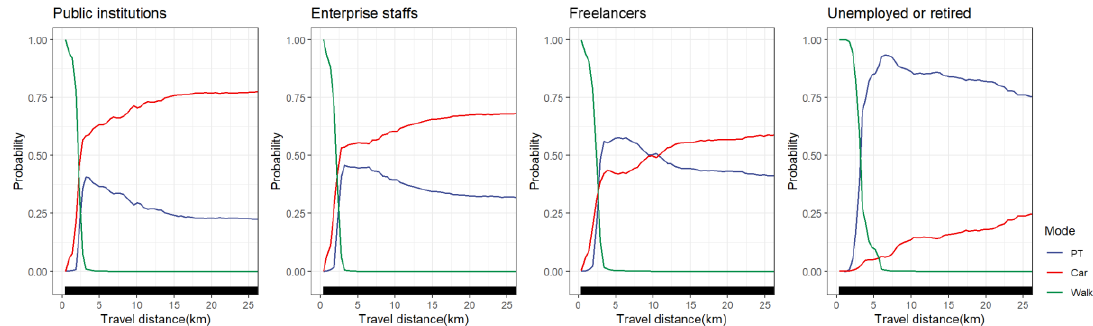
Figure 11. PDP plot of occupational groups differences.